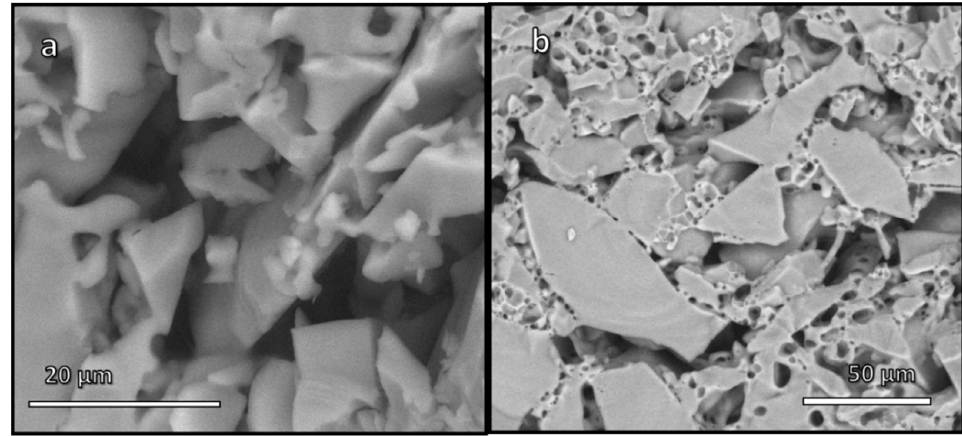
Figure 2. Microstructural details of porous materials from low temperature (550 °C) firing: ( a ) cell wall of a foam; ( b ) membrane .